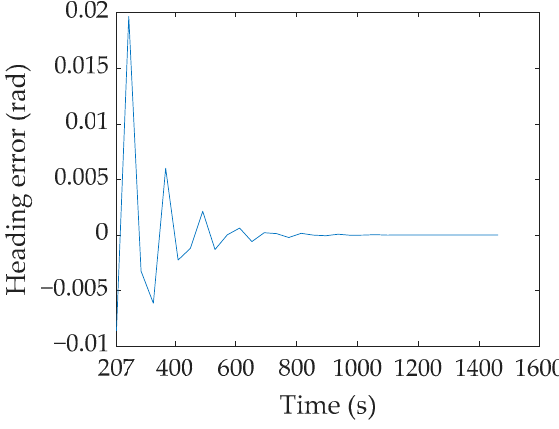
Figure 10. Cross-track heading angle error for the straight line.